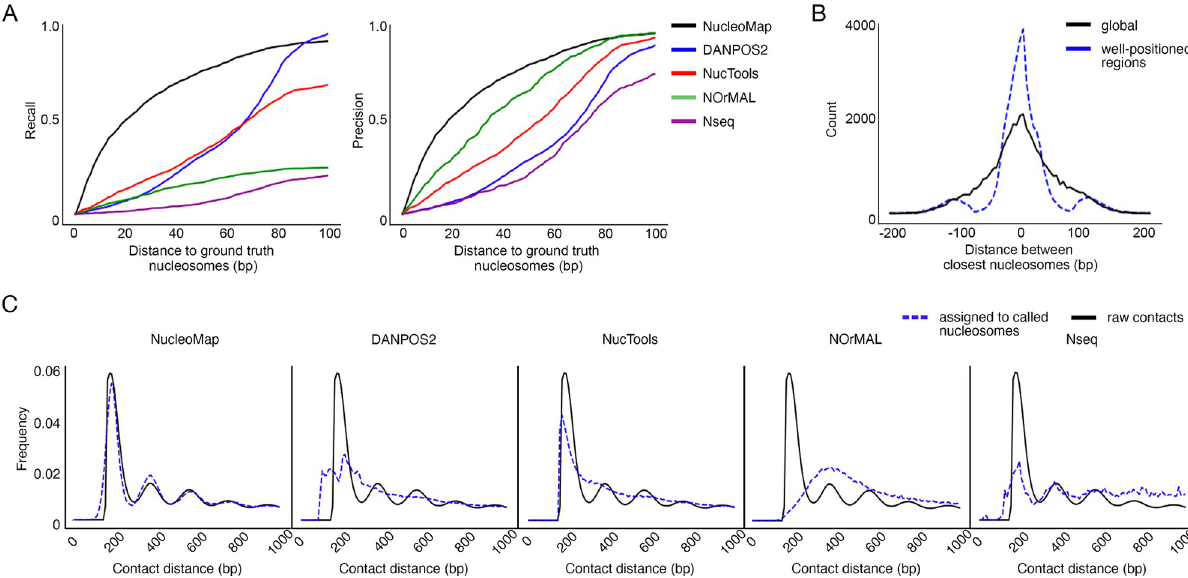
Fig 2. NucleoMap outperforms baseline methods in yeast and hESC. NucleoMap locates nucleosome centers with the following steps: A. (left panel) Recall of nucleosomes identified by different approaches against the corresponding distance thresholds in yeast chrIII. The recall is calculated by n(true- positive nucleosomes)/n(ground truth nucleosomes). Here “true-positive” nucleosomes refer to nucleosomes located within certain distance thresholds from a “ground truth” nucleosome, while the “ground truth” nucleosomes are experimentally confirmed nucleosomes. Smaller distance thresholds correspond to more accurate nucleosome locations, while a higher recall corresponds to more identified ground truth nucleosomes. Therefore, the area under the curve represents the sensitivity of the corresponding methods in identifying nucleosomes (right panel). The precision of nucleosomes identified by different approaches against the corresponding distance threshold in yeast chrIII. Precision is calculated by n(true-positive nucleosomes)/ n(identified nucleosomes). A higher consensus nucleosome ratio represents fewer “false-positive” nucleosomes identified, and thus the area under the curves represents the nucleosome identifying specificity of the corresponding methods. B. Distance between nucleosomes identified by NucleoMap (NucleoMap nucleosomes) and their nearest nucleosomes identified by DANPOS2 (DANPOS2 nucleosomes) in different regions. Compared with random regions in the whole genome, NucleoMap nucleosomes are much closer to the nearest DANPOS2 nucleosomes in well-positioned regions, showing the consistency in well-positioned regions across the two methods. C. Histogram of contact distance (black) and histogram of inter- nucleosome distance characterized by computational methods (blue) in hESC chr21. The peak patterns of contact distance reflect genome-wide nucleosome repeating lengths (NRL). Similar histograms between raw contact distance and computationally characterized inter-nucleosome distance suggest accurate nucleosome